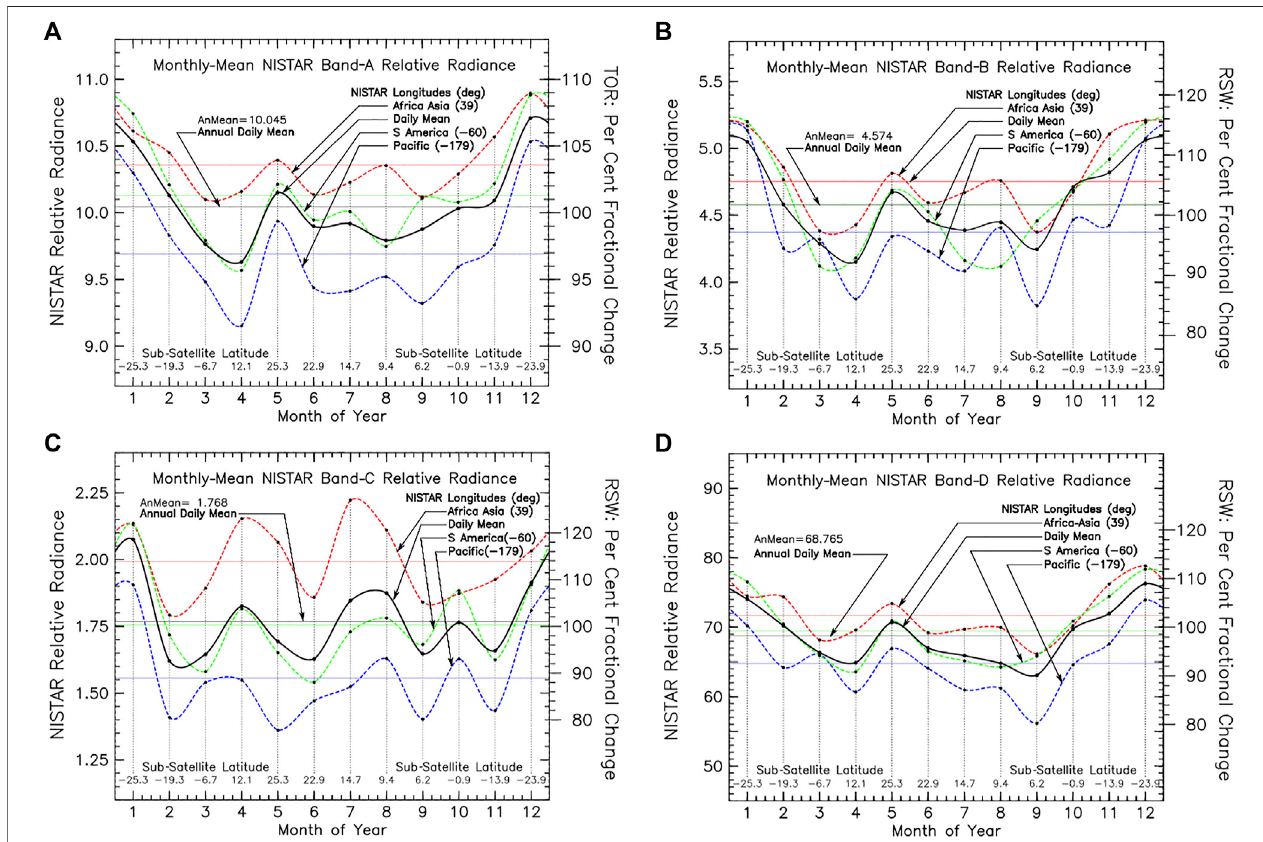
FIGURE 3 | Four-hour averaged NISTAR measurements for year 2017 of the longitudinally sliced seasonal variability of the Band-A (0.2 – 100 μ m) Total Outgoing Radiation TOR (A) , Band-B (0.2 – 4 μ m) Re fl ected Solar Radiation RSR (B) , Band-C (0.7 – 4 μ m) Near-Infrared Re fl ected Solar Radiation NIR (C) , and Band-D Silicon Diode (0.3 – 1.1 μ m) Visible Re fl ected Solar Radiation VIS (D) . The heavy black lines depict (longitudinal) full day averages. The colored lines represent the longitudinal slicing as the Earth rotates, whereby the speci fi ed geographical area with the high-noon Sun is also identi fi ed by its central meridian. The seasonal change in the Lissajous orbital sub-satellite latitude is tabulated at fi gure